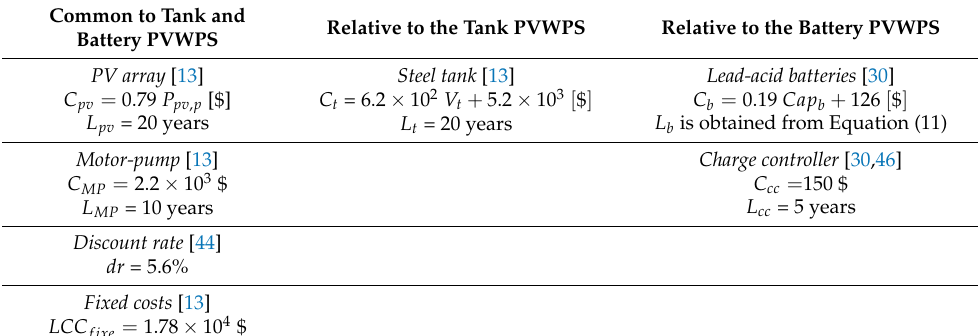
Table 2. Economic parameters for Gogma. Common to Tank and Relative to the Tank PVWPS Relative to the Battery Battery PVWPS